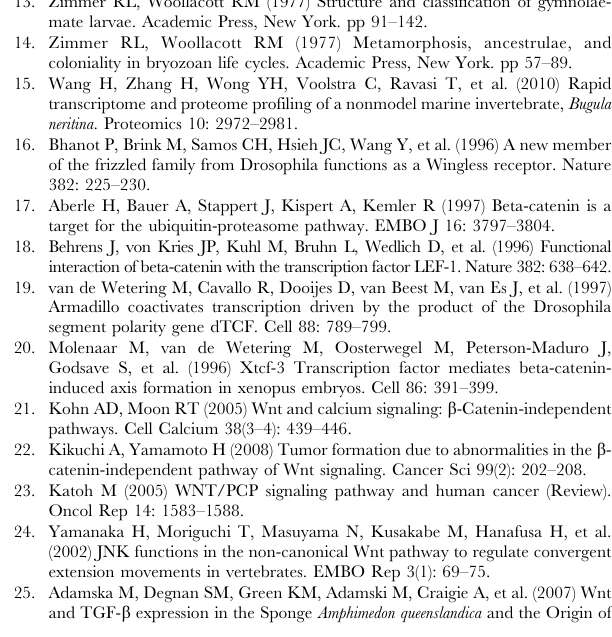
Figure S1 Maximum likelihood phylogenetic orthology assignment of (A) Wnt s, (B) Frizzled receptors and (C) secreted Frizzled Related Protein. (1000 bootstrap replicates). Figure S2 Possession of N-terminal signal peptide as (C) BnsFRP . (DOCX) Figure S3 Alignment of (A) BnWnt6 and (B) BnWnt10 with reference sequences. Conserved cysteine residues were bolded and highlighted in red color. Signal peptides were highlighted in purple. Asn-link glycoxylation sites were highlighted in green. (DOCX) Table S1 Sequence reads from the Bugula neritina transcriptome (NCBI accession number: SRA010777.2) and the corresponding gene-specific primers. (XLSX) Table S2 Primers for the qRT-PCR assay.